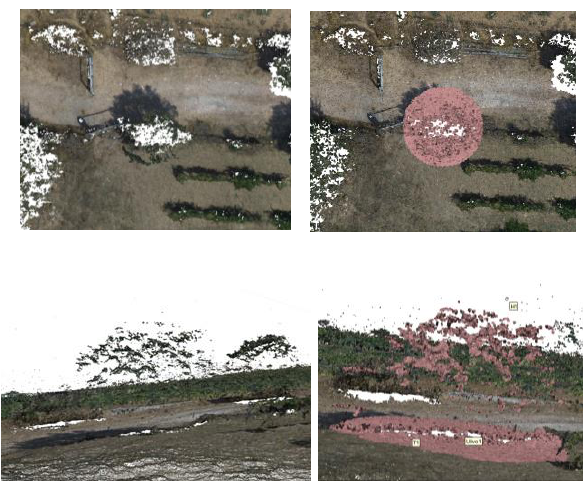
Figure 12. Tree height measurement